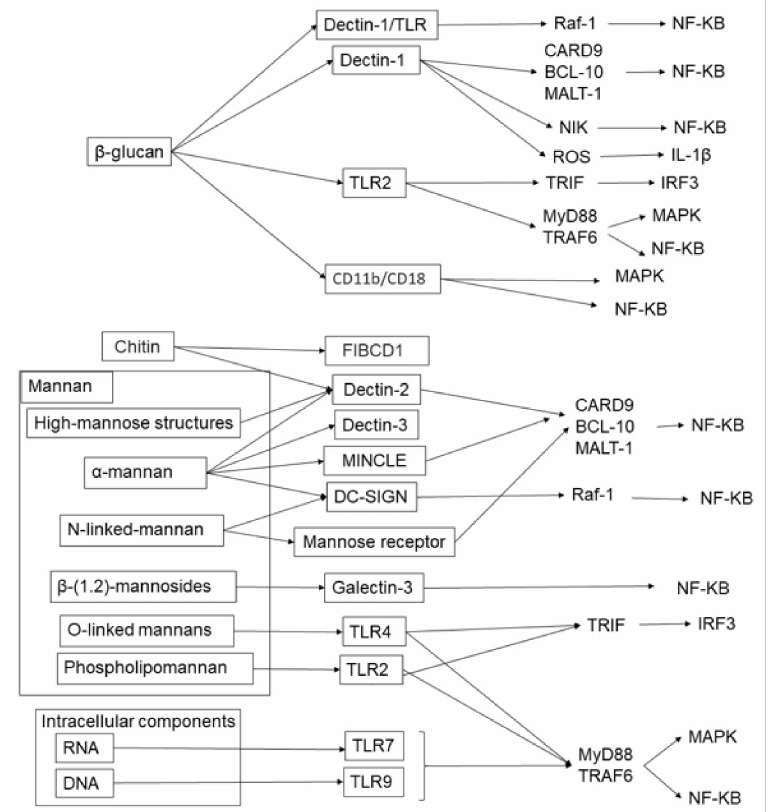
Figure 2. Fungal cell components and their receptors in